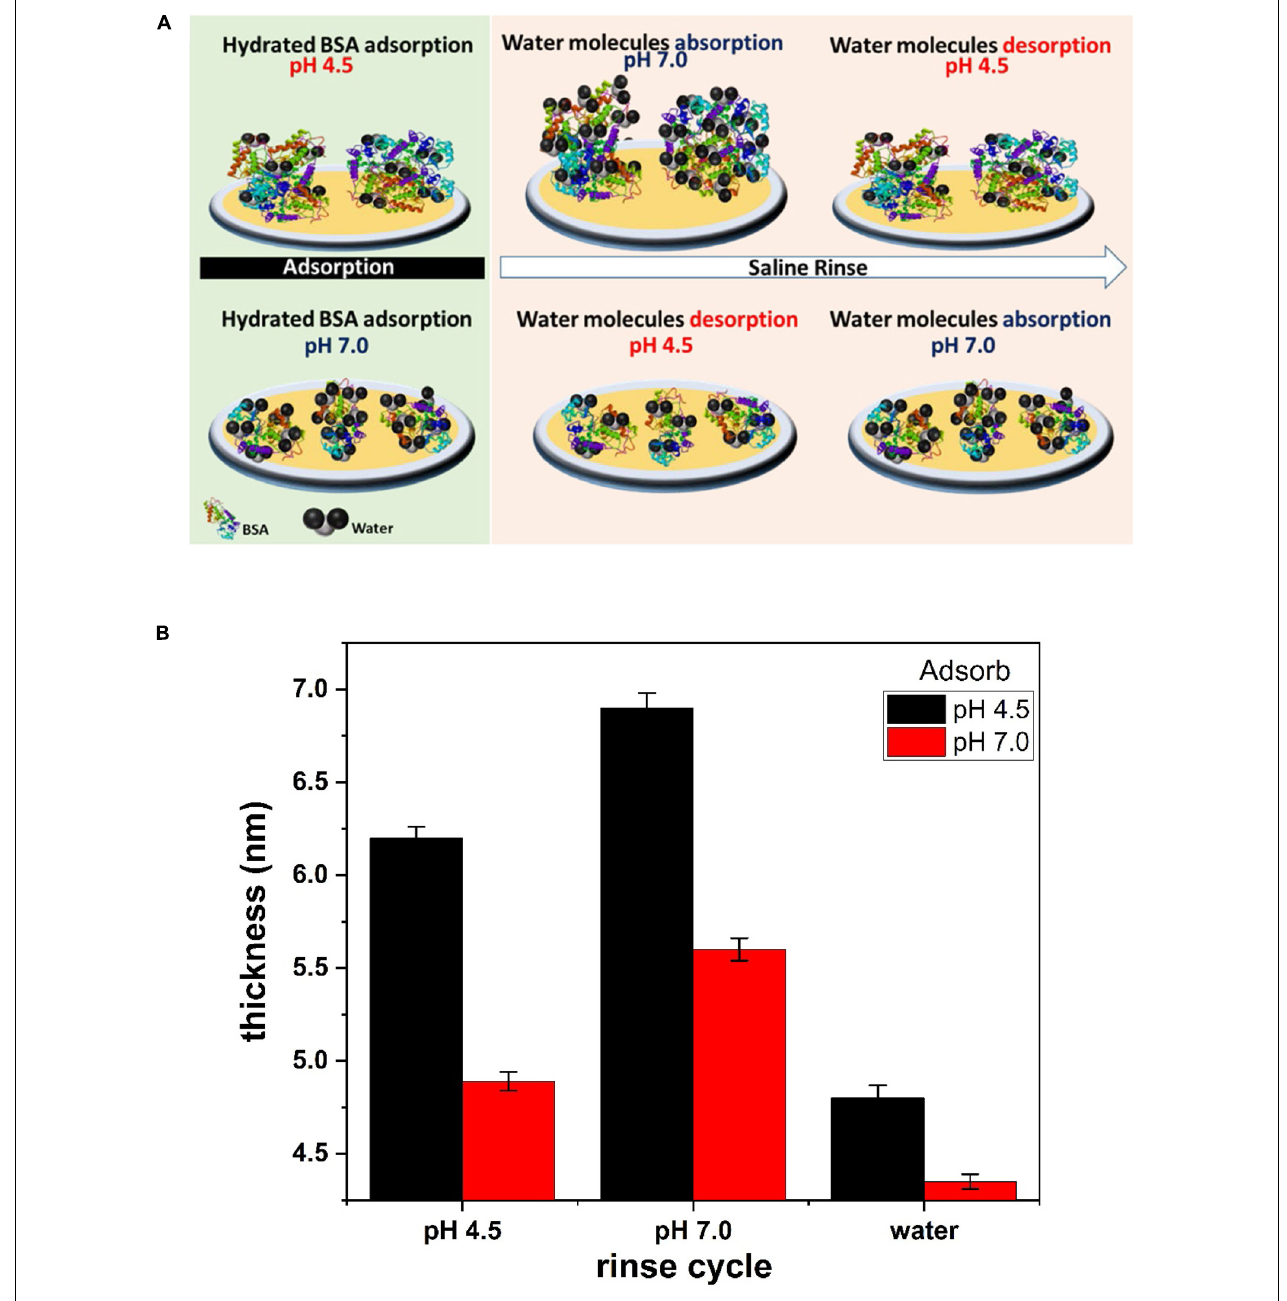
FIGURE 6 | (A) Schematic representation of BSA sorption and conformation on the liquid/gold interface at pH 4.5 and 7.0. Saline rinse of BSA layer adsorb/desorb water molecules at pH 7.0/4.5. (B) Thickness of the BSA layer evaluated from the Sauerbrey model. The hydrated BSA layer adsorbed at pH 4.5 and pH 7.0 is plotted at different saline and water rinse